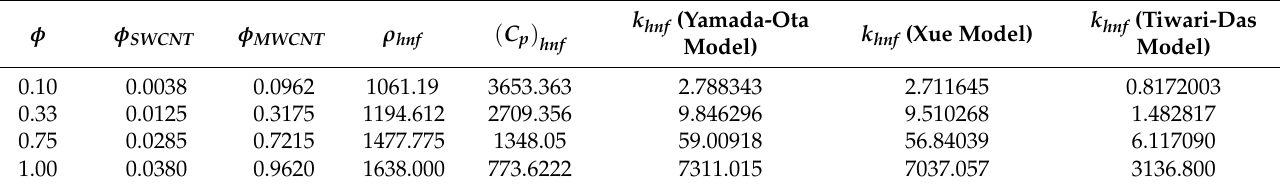
Table 2. Physical properties of hybrid nanofluid.